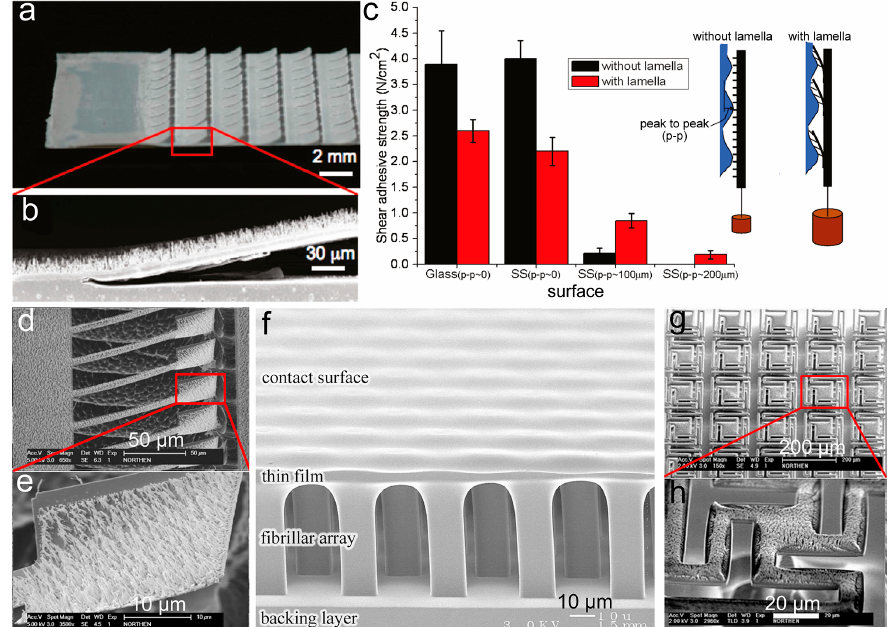
Figure 7. Different lamella–pillar hybrid (LPH) structures. ( a , b ) High ‐ density polyethylene